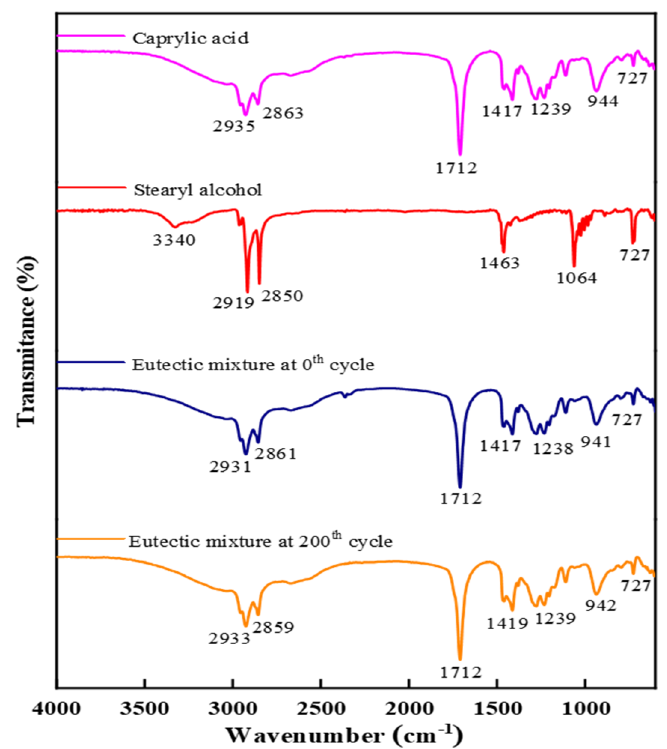
Figure 9. FT ‐ IR of the pure materials and prepared eutectic